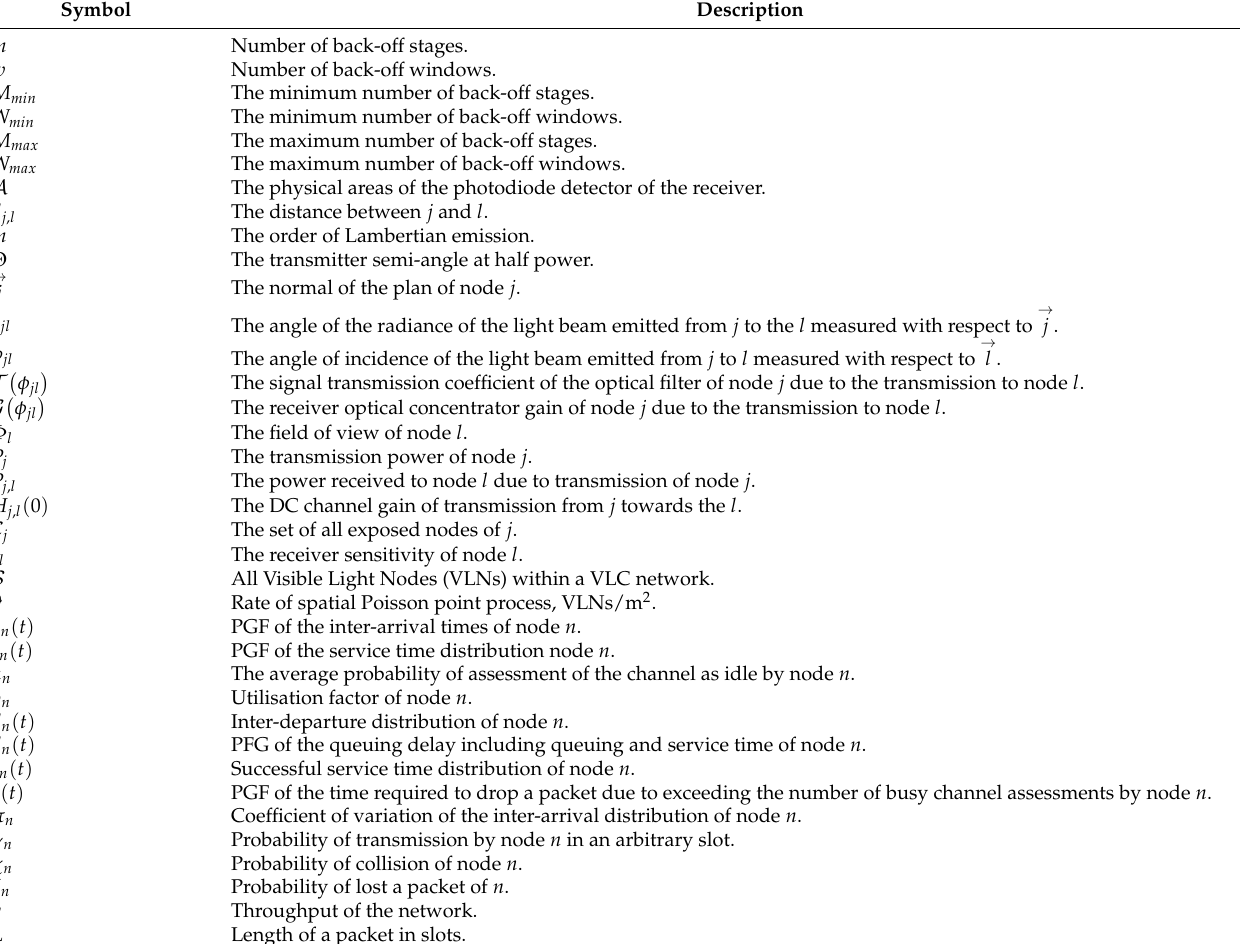
Table 2. Key symbols of the MSAM and their